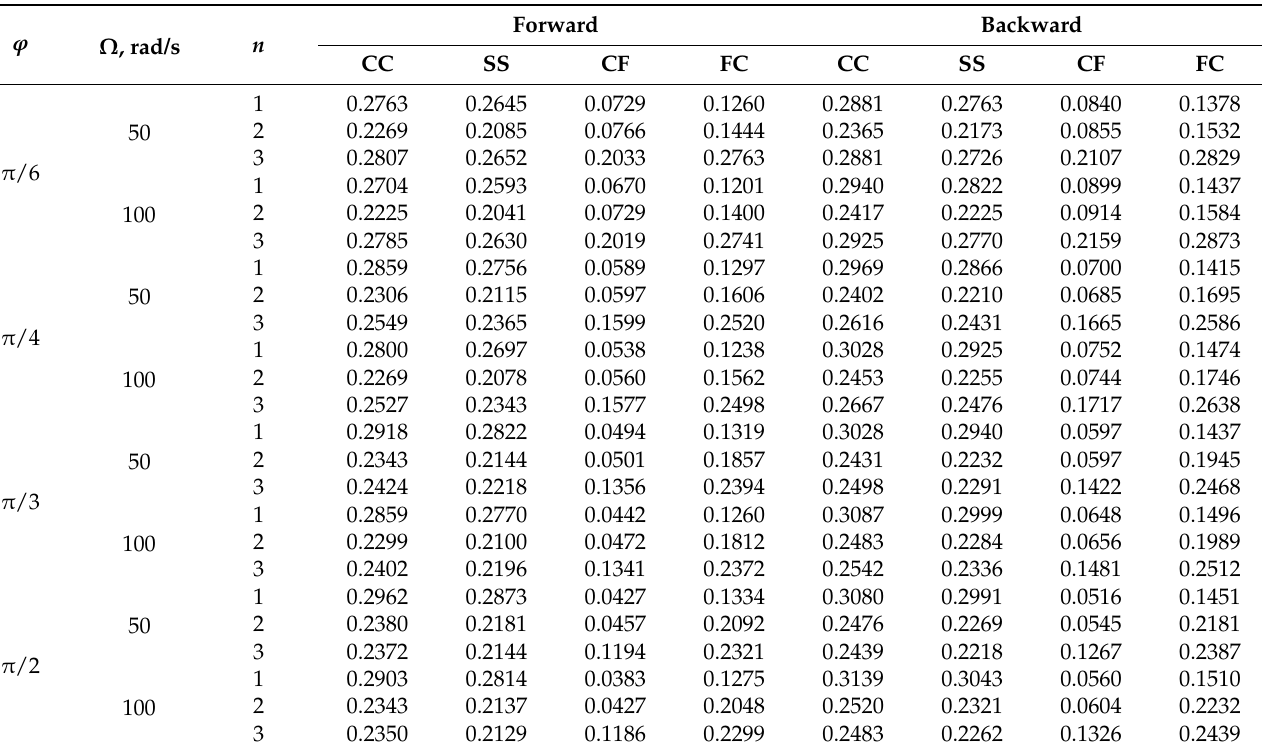
Table 6. Dimensionless frequencies of rotating laminated combined conical-cylindrical shell with ∆ T = 50